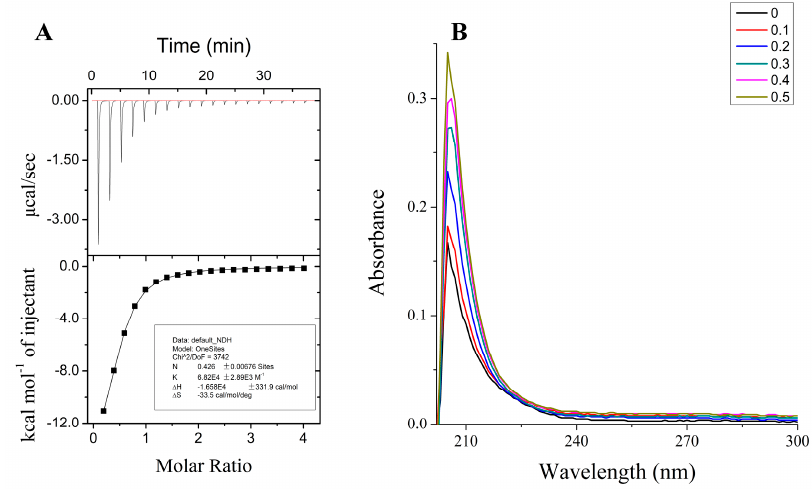
Figure 2. Properties of Zn 2+ binding to the third repeat unit of the microtubule-binding domain of tau (tau-R3). ( A ) Calorimetric titration of Zn 2+ to tau-R3. The top panel represents the raw data for sequential two- µ L injections of Zn 2+ into tau-R3. The bottom panel shows the plot of the heat evolved (kilocalories) per mole of Zn 2+ added against the molar ratio of Zn 2+ to tau-R3. The data (solid square) was best fitted to a model with a single set of identical sites, and the solid line represents the best fit. ( B ) Spectrophotometric titration of Zn 2+ to tau-R3, Zn 2+ /tau-R3 ratio ranges from 0–0.5. 2.2. Zn 2+ Accelerated the Fibrillization of Tau-R3 In Vitro The fibrillization of tau-R3 incubated alone or with different cations (Mn 2+ , Mo 5+ , Fe 3+ , or Zn 2+ )